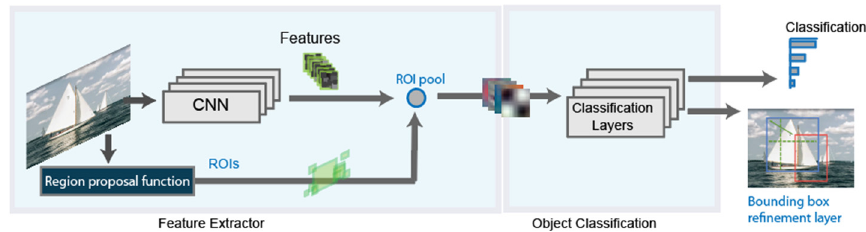
Figure 2. Basic schema of the Fast RCNN detector.